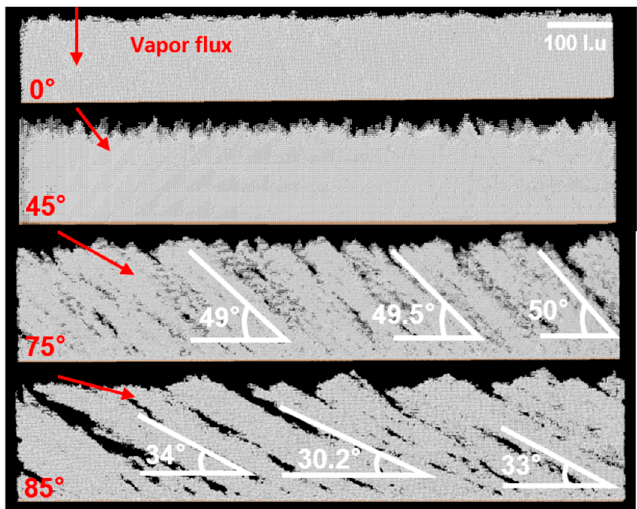
Figure 10. Simulated nanostructure thin film under different deposition angles.